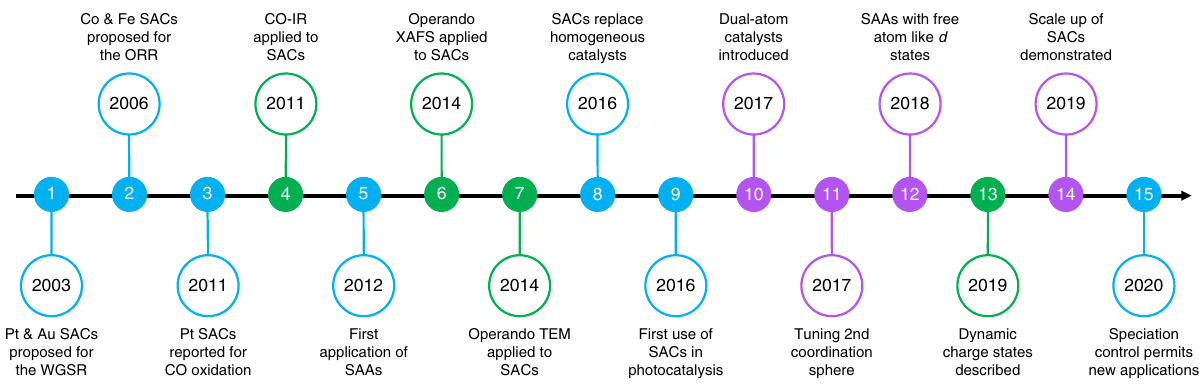
Fig. 1 Progress in single-atom catalysis. Timeline showing landmarks (L = 1 – 15) leading up to and during the last decade of research on the synthesis (purple), characterization (green), and application (blue) of single-atom metal catalysts. ORR oxygen reduction reaction, WGSR water – gas shift